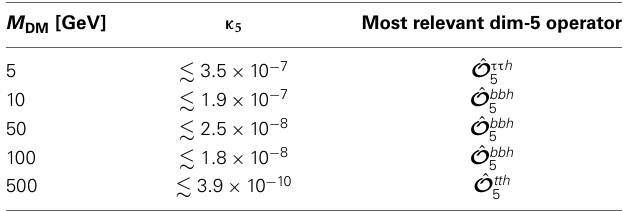
Table 1 | DM mass and upper bound of κ 5 for DM lifetime larger